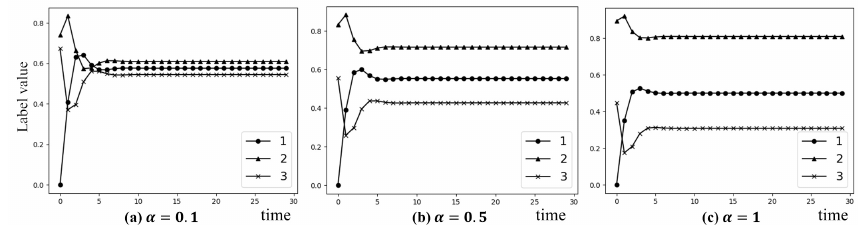
Figure 11. The effect of α on the label value of node 3. The larger α makes node 2 have more influence on node 3 than the